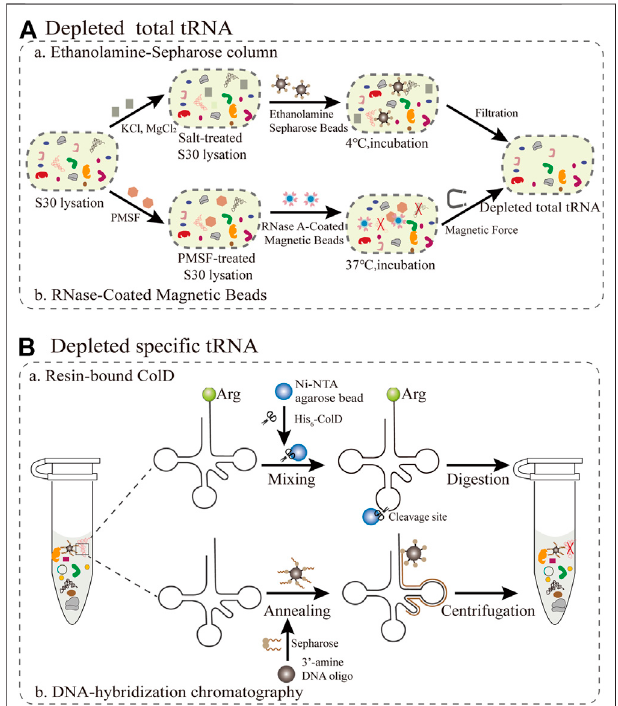
FIGURE 3 | Emerging methods for removing all or individual tRNAs during S30extraction (A) TheremovaloftotaltRNAs fromS30extractsbased on ethanolamine agarose and RNase-Coated Magnetic Beads (B) Resin- bound ColD and DNA-hybridization chromatography for the removal of speci fi c